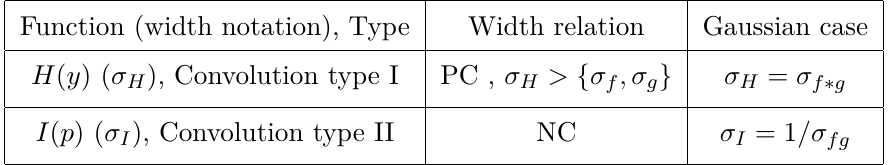
Table 2 . Properties of the width of functions H and I for convolution with an addition complex phase in terms of their origin functions f and g , giving rise to an additional term I ( p )